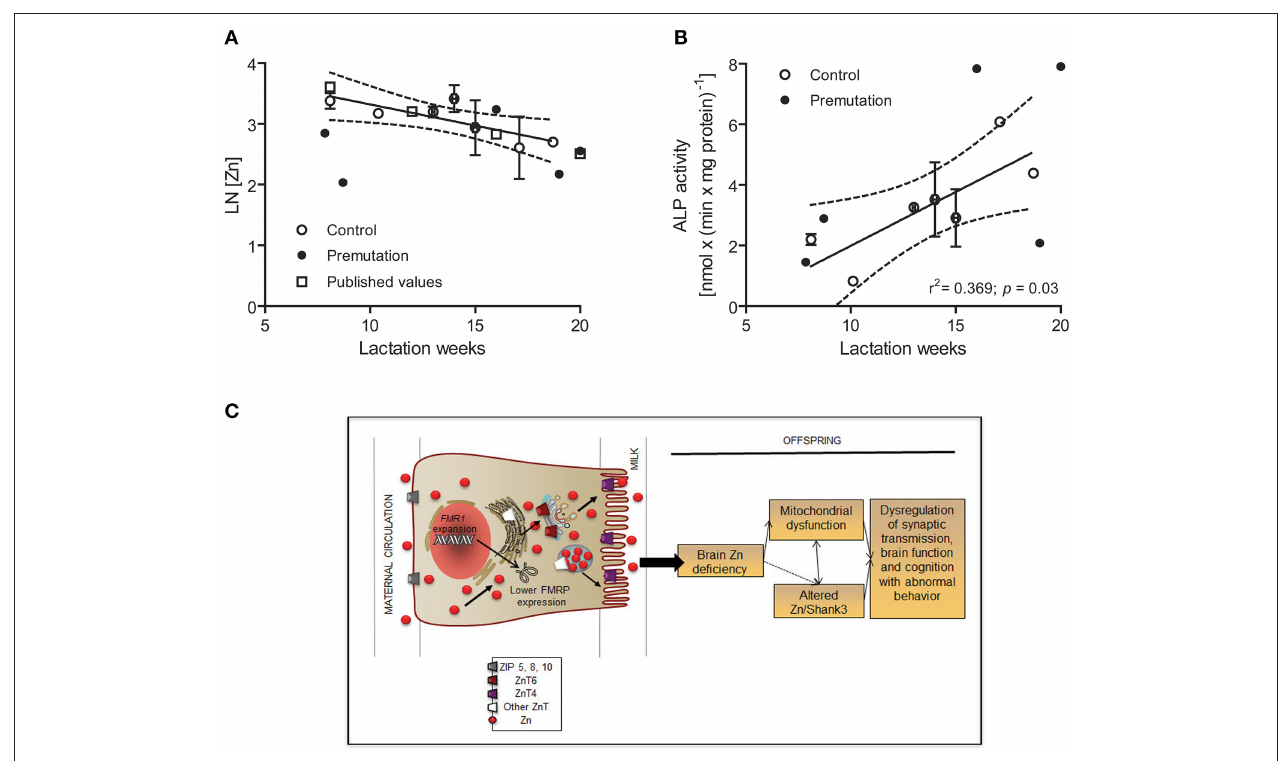
FIGURE 11 | Role of milk Zn in brain bioenergetics and synapse scaffolding in premutation carriers. Milk-Zn concentrations followed a pseudo-first order kinetics over the lactation period (A) . Milk Zn concentrations from control and premutation donors decreased with the post-partum period, ranging from 30 ± 3 µ M at 6–8 weeks to 15 ± 2 µ M at 18–20 weeks. The LN values of the Zn concentrations (in µ M) were plotted against lactation week. The published values were obtained from Nagra et al. (Nagra, 1989) and shown as white squares. Regression parameters are as follows: for published [Zn], r 2 = 0.997, y = − 0.09x + 4.3; for this study, r 2 = 0.647, y = − 0.07x + 4.0. P value for slopes = 0.458; P value for intercepts = 0.986. ALP activity [expressed as nmol × (min × mg protein) − 1 ] in human breast milk from control donors increased linearly from 8 to 18–20 weeks (B) . The average ALP activity of controls was 3.3 ± 0.3 nmol × (min × mg protein) − 1 or 46 ± 1 µ mol × (min × l) − 1 and within reported values [40 to 60 µ mol × (min × l) − 1 ; ( Worth et al., 1981; Coburn et al., 1992)]. Linear regression analyses were performed with control values (reported as mean ± SEM) for both outcomes ( r 2 = 0.638 and 0.639 for Zn concentration and ALP activity, respectively). The 95% CIs performed with control values are shown with dotted lines. Individual premutation carriers’ values for Zn concentrations and ALP activities are shown in Table 5 . ALP activities in controls were not affected by vitamin and mineral supplementation [supplemented: 3.7 ± 0.4 vs. not supplemented: 3.2 ± 0.4 nmol × (min × mg protein) − 1 ; p = 0.624]. A model integrating experimental data based on altered Zn homeostasis, mitochondrial dysfunction [current study and ( Ross-Inta et al., 2010; Napoli et al., 2011)], and the putative effect of defective synaptic scaffolding in premutation individuals is shown in (C) . During lactation, Zn uptake is exerted by ZIP5, 8 and